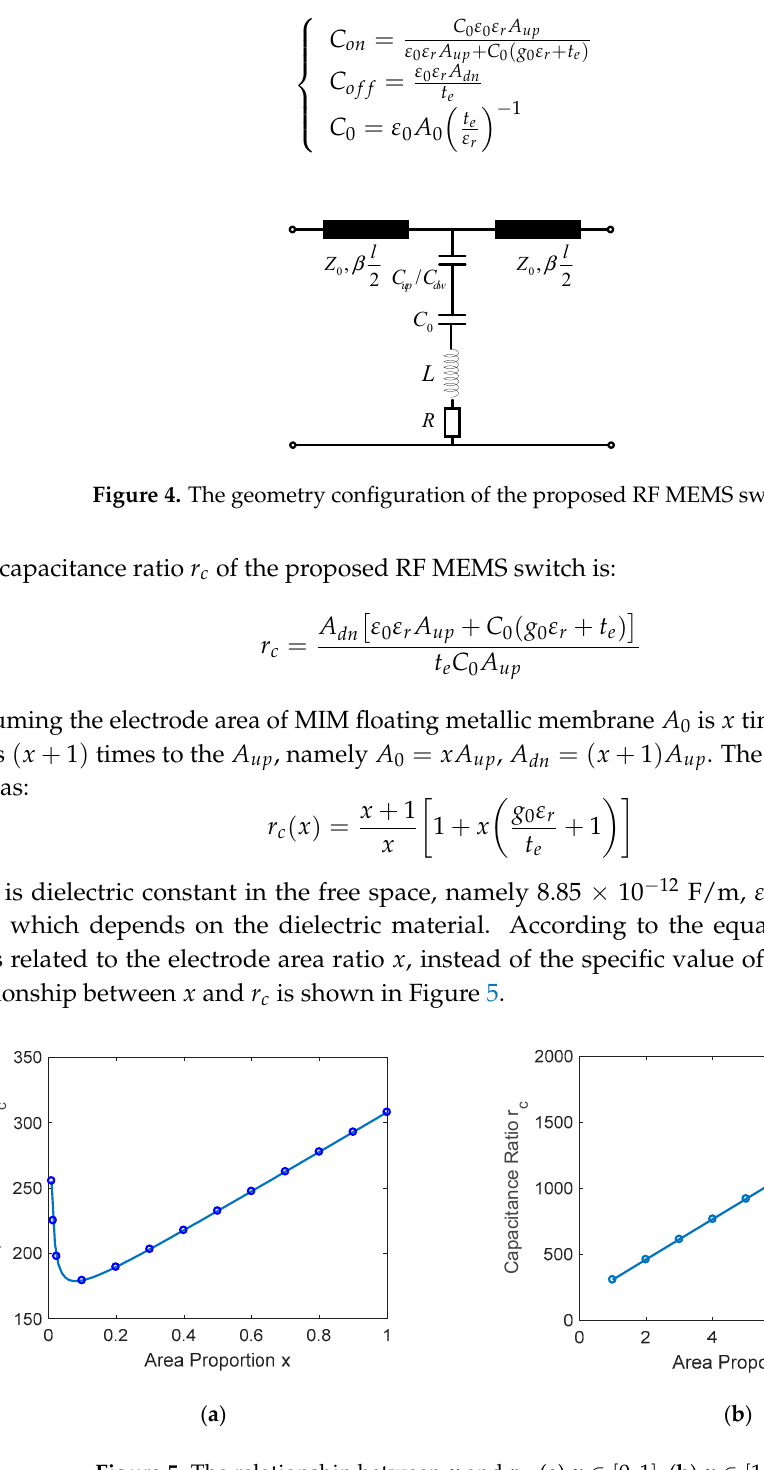
Figure 4. The geometry configuration of the proposed RF MEMS switch.